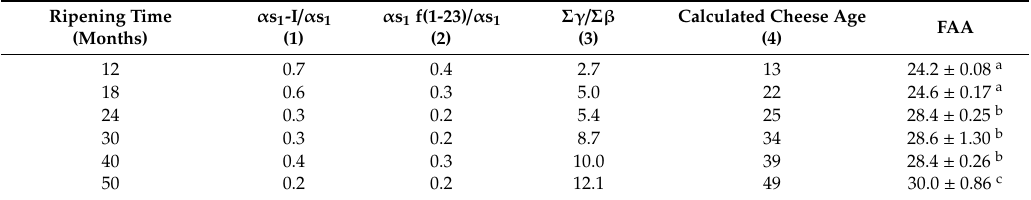
Table 2. Casein fraction ratios ( α s 1 -I / α s1, α s1 f(1-23) / α s1 and Σ γ / Σ β ), calculated cheese age (months) and total free amino acids (FAA) (g / 100 g protein) in Parmigiano Reggiano cheeses ripened from 12 to 50